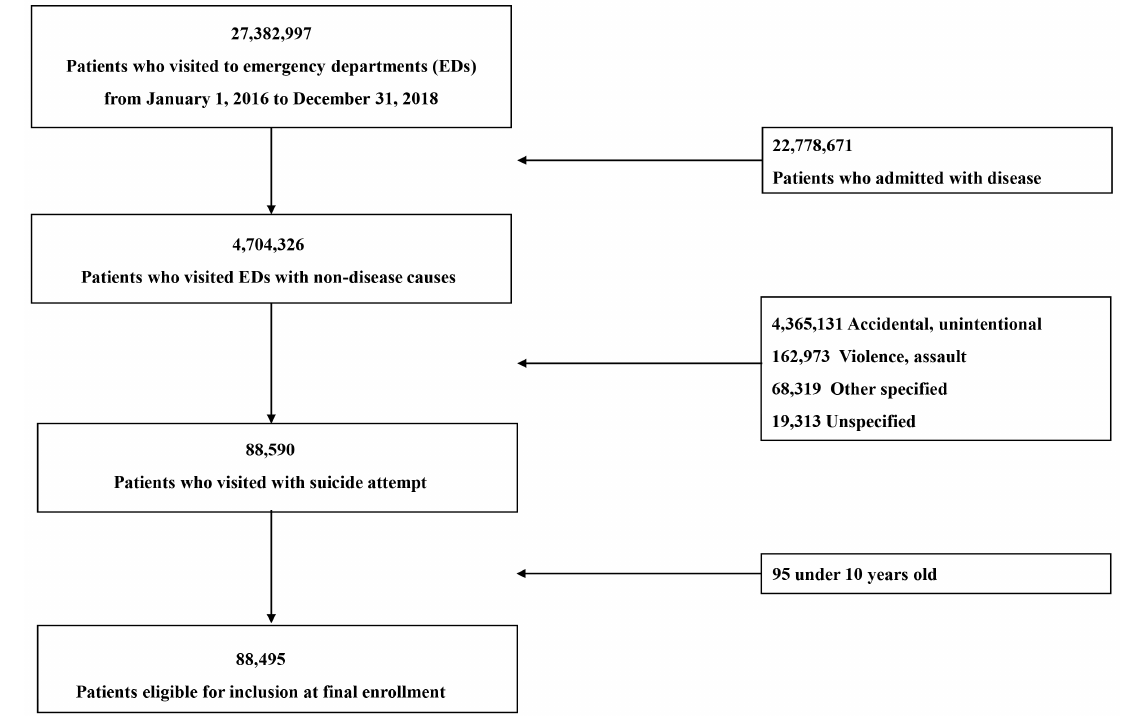
Fig. 1. Patient flow